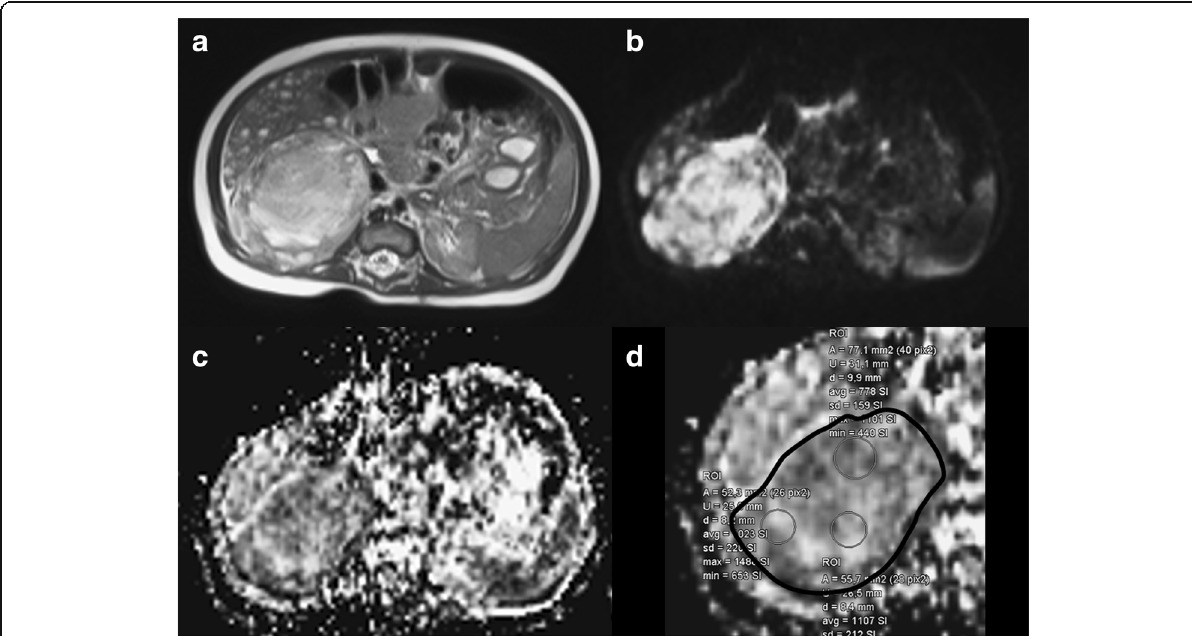
Fig. 2 Baseline MRI of a 5-week-old boy with neuroblastoma of the right adrenal gland and suspected multiple liver metastases shown on T2- weighted image ( a ), DWI with b = 800 s/mm 2 ( b ), and ADC map ( c ). To demonstrate the large region of interest (ROI) technique used in our study for ADC quantification, d presents a magnification of c with a solid black line as overlay marking the free-hand ROI drawn along the tumour margins. Mean ADC of the tumour was measured as 0.883 × 10 − 3 mm 2 /s, and the patient did not suffer a tumour relapse. Three additional small circular ROIs yielded ADC values from 0.778 to 1.107 × 10 − 3 mm 2 /s, indicating some ADC variability in the visually rather homogeneous tumour. The small ROI data were not used in the present